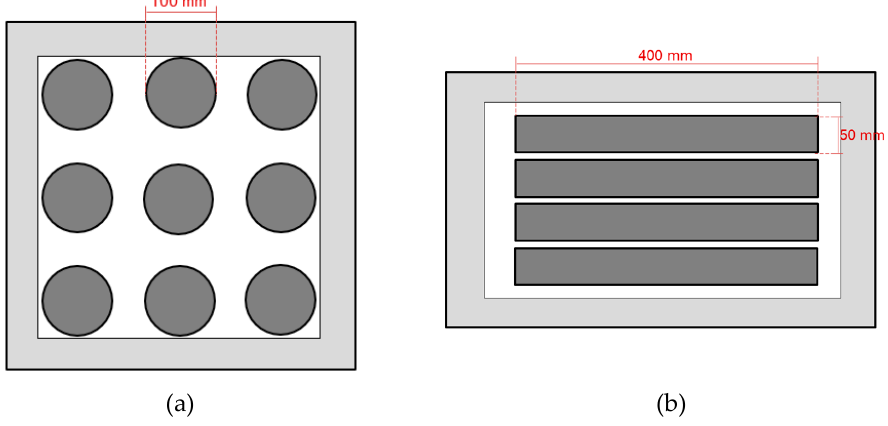
Figure 5. Cylinder and beam samples’ detailed drilling/cutting schematic: ( a ) cylinder samples drilled from Slab_type_1 and ( b ) beam samples cut from Slab_type_2.